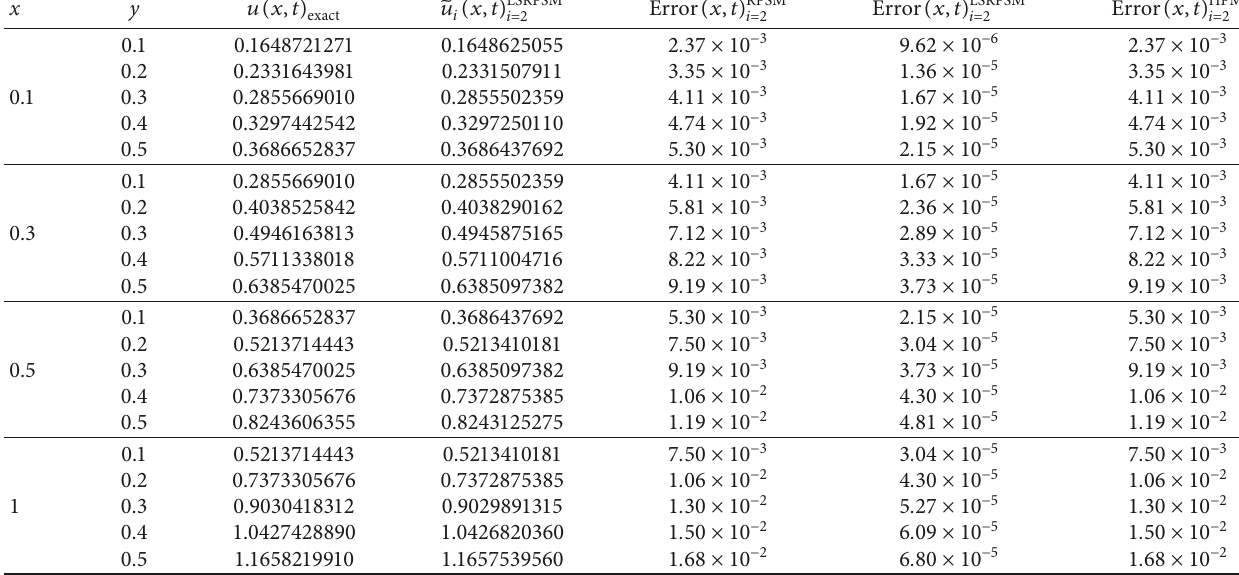
Figure 5: 3D graphics of exact and approximate solutions. (a) 􏽥 u ( x, t ) Table 5: Absolute errors by LSRPSM, RPSM, and HPM for α �